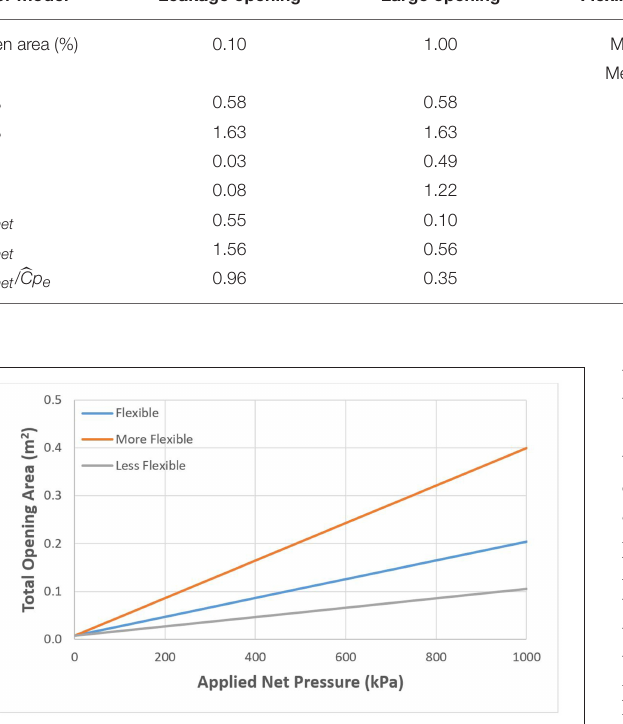
TABLE 4 | Open area and pressure means and maxima of fixed and flexible open area cases. Door model